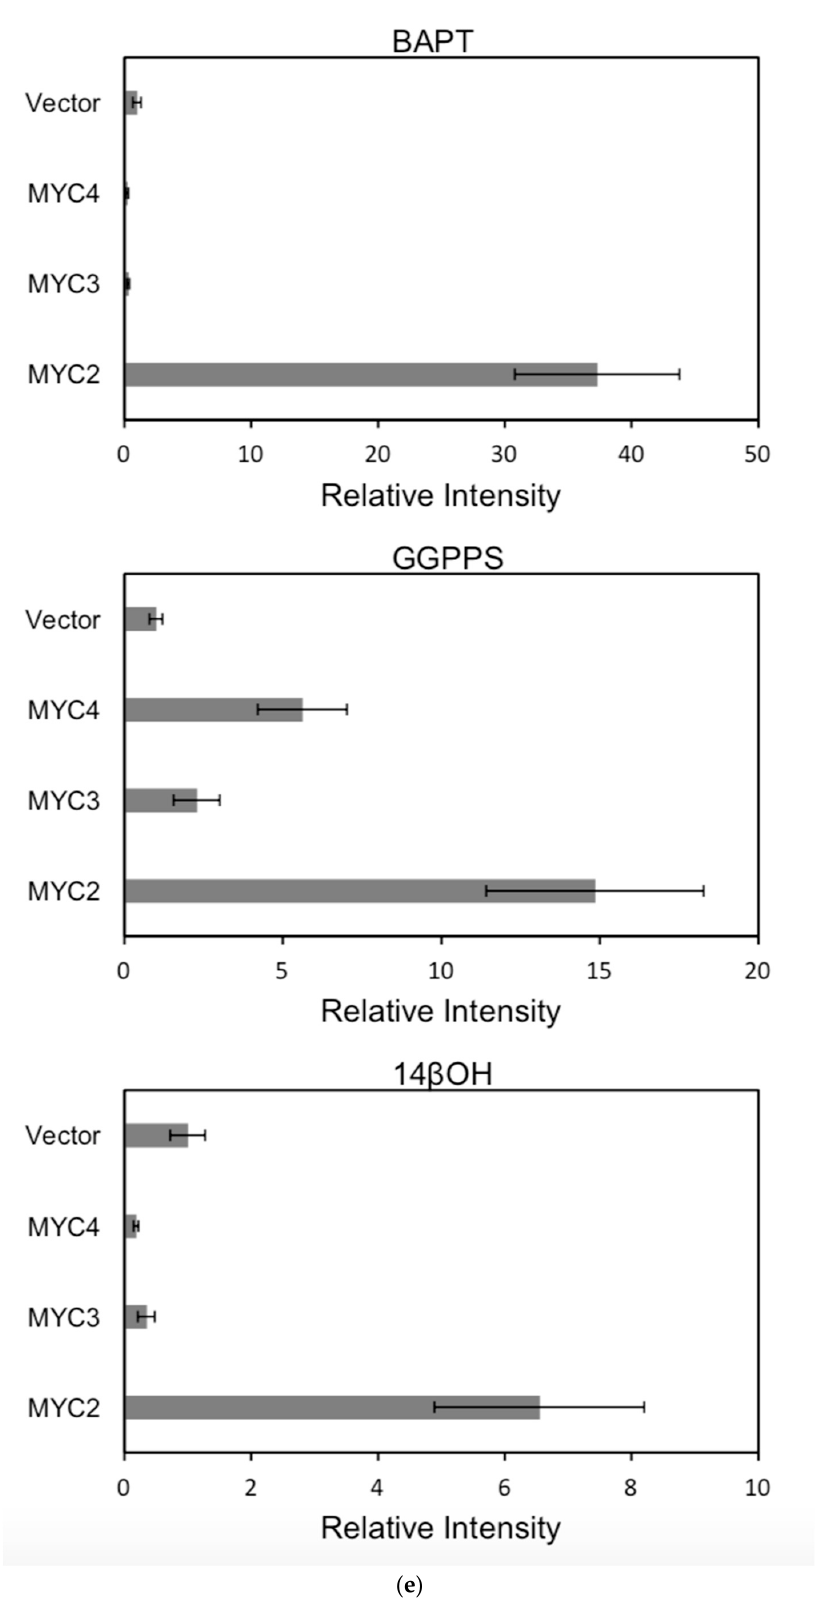
Figure 6. (a) transcriptional activity of MYC2, MYC3 and MYC4 on the paclitaxel synthesis pathway genes TAT and TBT promoters(Results are presented as a LUC/REN ratio. n = 3 in all samples, error bars are SE(TBT group, * p = 3.26e-6; TAT group, * p = 7.26e-6 ); (b) transcriptional activity of MYC2,